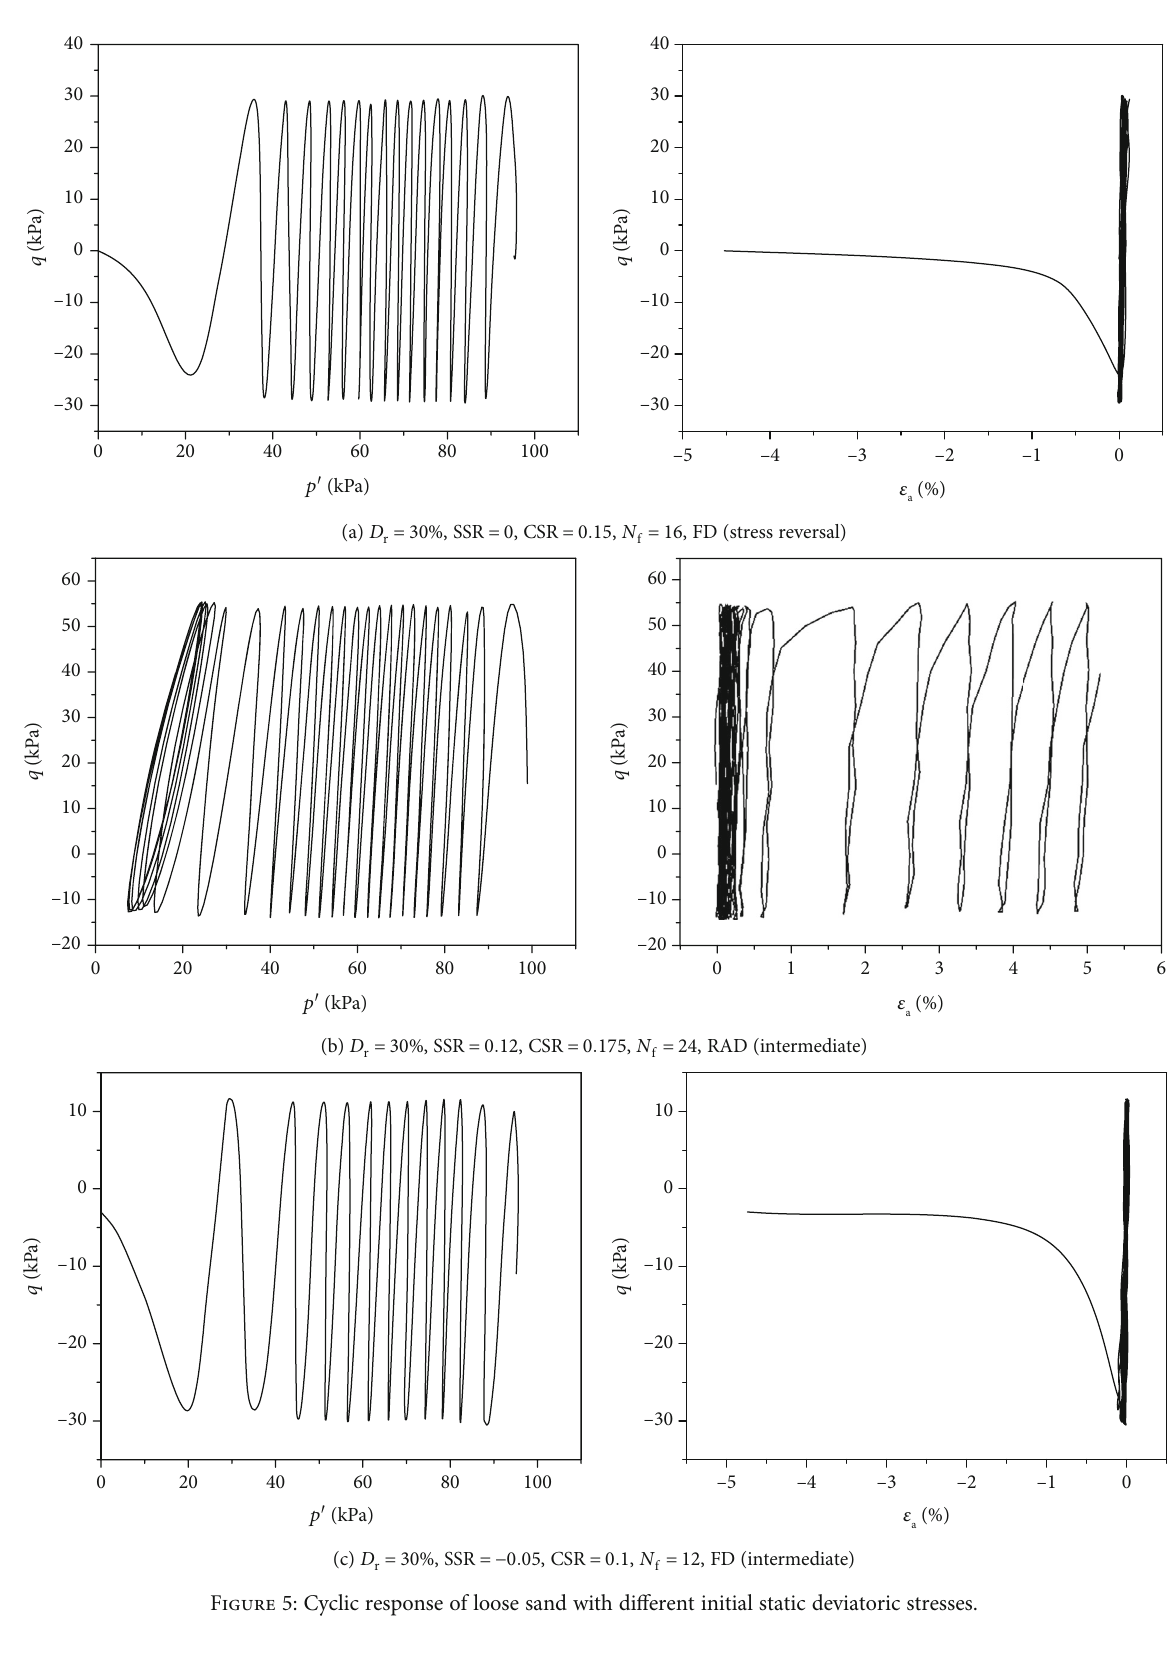
Figure 5: Cyclic response of loose sand with di ff erent initial static deviatoric